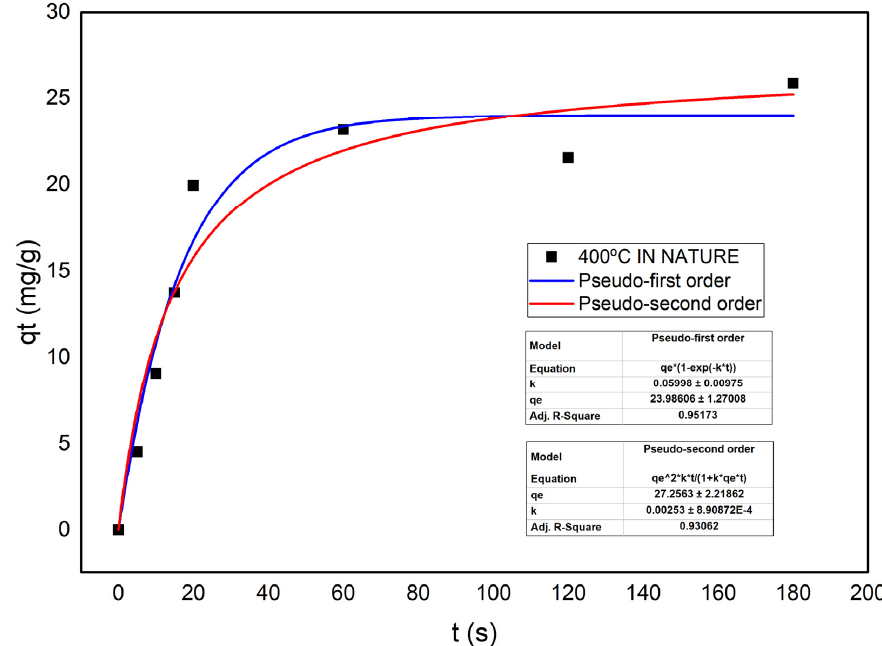
Figure 10. Pseudo-first-order and pseudo-second-order models for adsorption experiment of in nature biochar obtained at 400 °C.